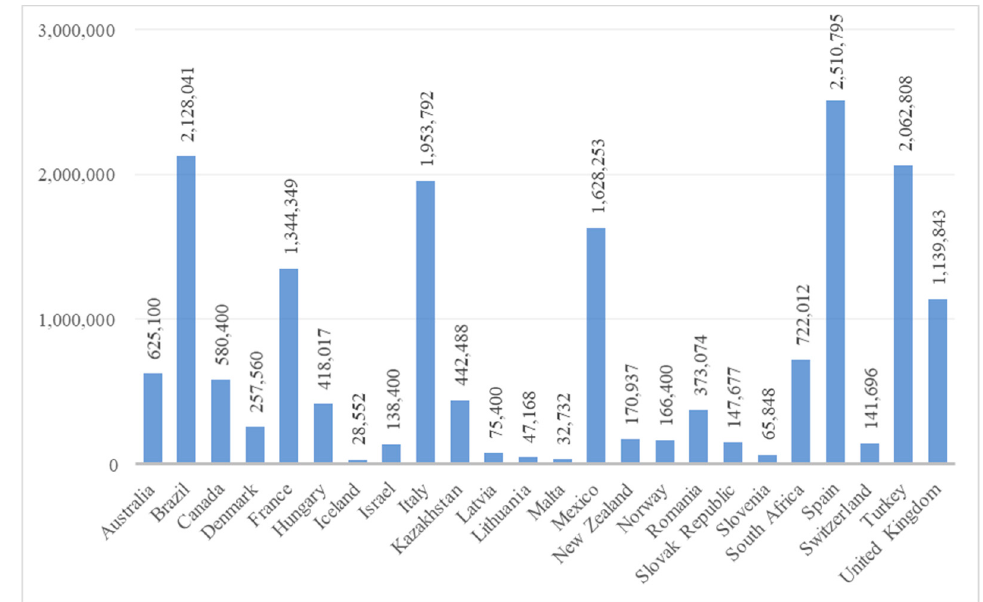
Figure 1. Employment in the tourist sector in 2017. Countries in alphabetical order. Source: OECD data for 2017.